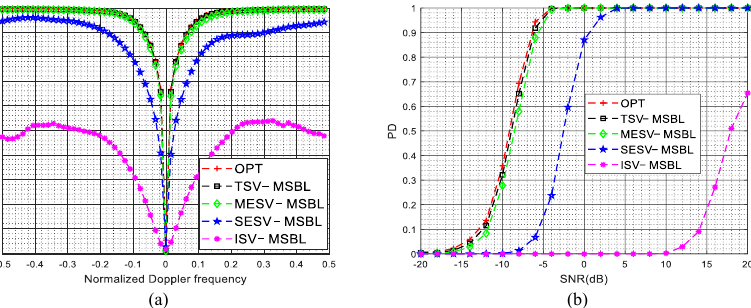
Figure 11. SINR loss curves and PD versus SNR curves in the presence of arbitrary array errors. ( a ) SINR loss versus the normalized Doppler frequency in the presence of arbitrary array errors; ( b ) PD versus SNR ( f st = 0.1) in the presence of arbitrary array errors.